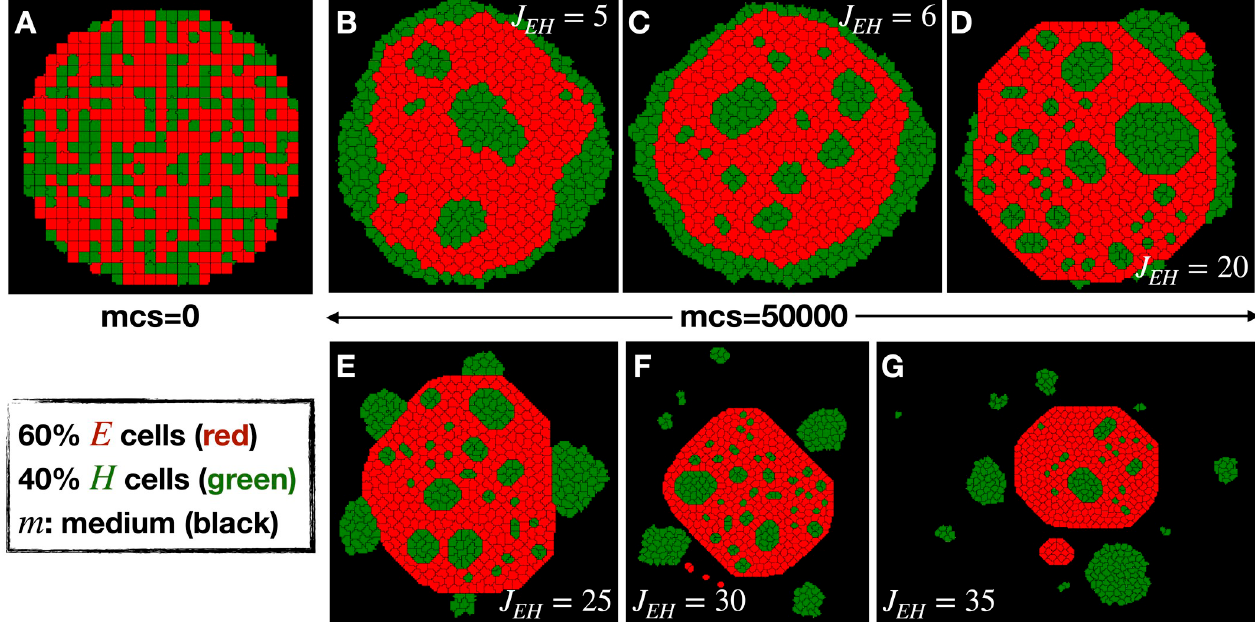
Fig 1. Dissemination of cells with diffusive motility. (A) Representative snapshot of initial condition of all the simulations consists of a primary tumor made of 60% nonmotile E cells (red) and randomly chosen 40% motile H cells (green) inside the medium (black) made of no cells. The representative final snapshots of the simulations at mcs = 50000 for different values of J = (B) 5, (C) 6, (D) 20, (E) 25, (F) 30 and (G) 35 in case of only fluctuation-based motilities of the EH cells (in the absence of active motility) at T H =